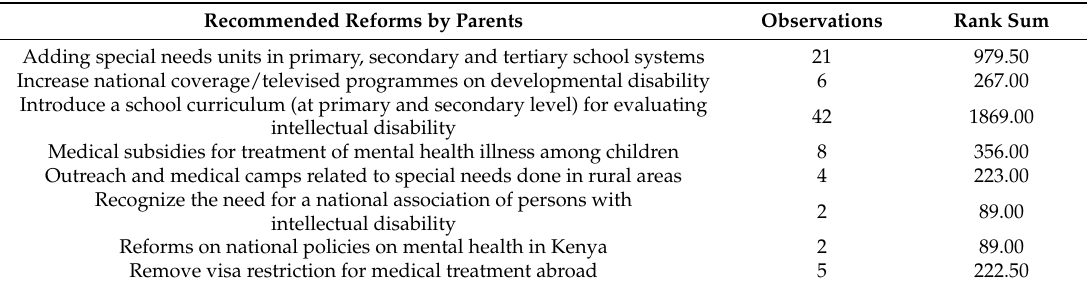
Table 3. Recommended reforms by